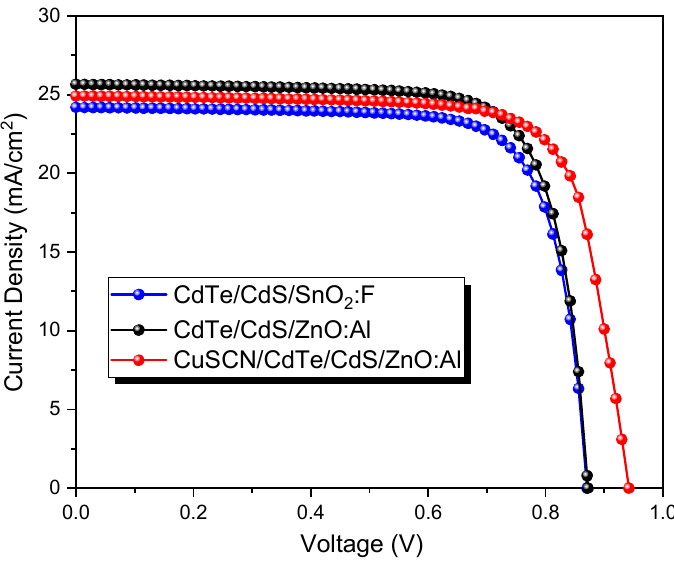
Figure 9. J-V curves of CdTe solar cells with different configurations.